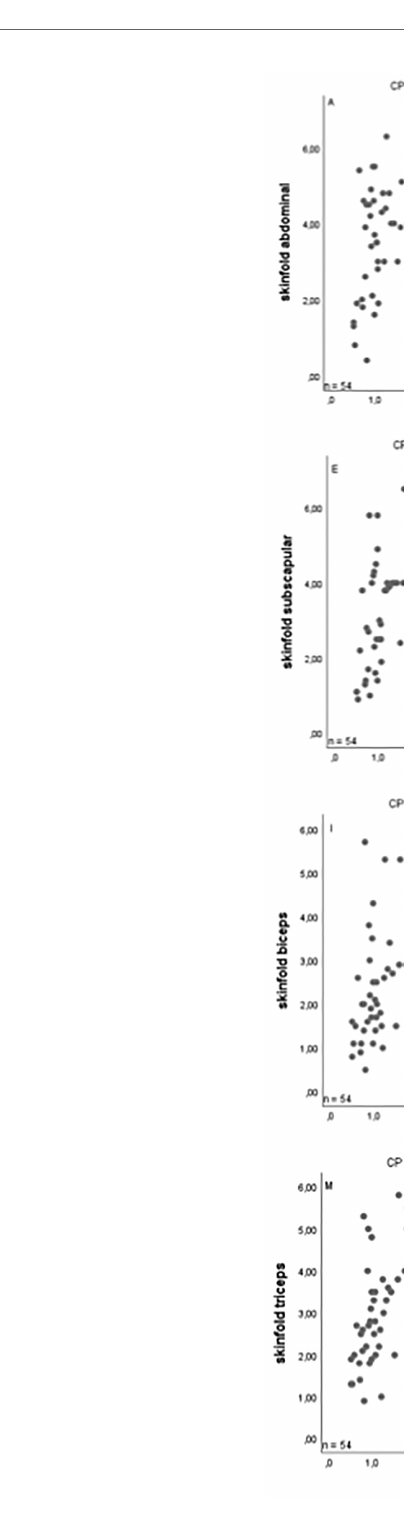
FIGURE 3 | Correlations between nuchal skinfold thickness (NST) as measured (cm) on cranial magnetic resonance imaging (MRI) and caliper-measured skinfold thickness for abdominal (A – D) , subscapular (E – H) , biceps (I – L) and triceps (M – P) skinfold thickness in patients with childhood-onset craniopharyngioma (CP) (A, E, I, M) , WHO grade 1 or 2 brain tumor (BT) patients (B, F, J, N) , WHO grade 3 or 4 BT patients (C, G, K, O) , and healthy controls (HC) (D, H, L, P) . r = Pearson correlation coef fi